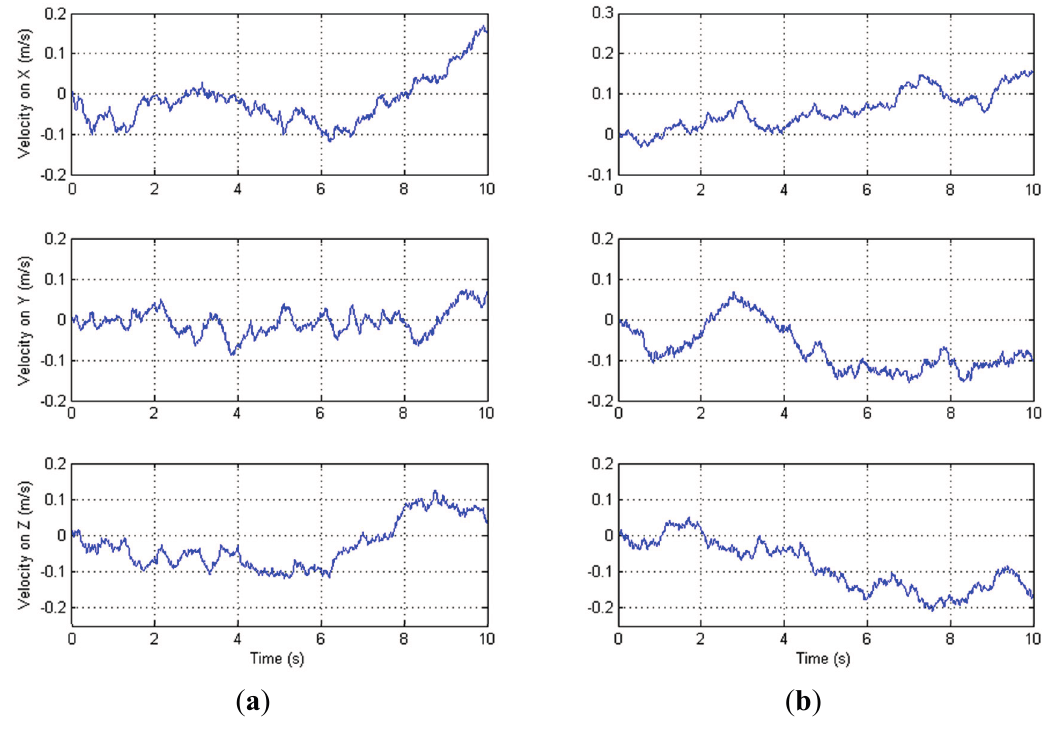
Figure 7. ( a ) Actual velocity; ( b ) Simulated